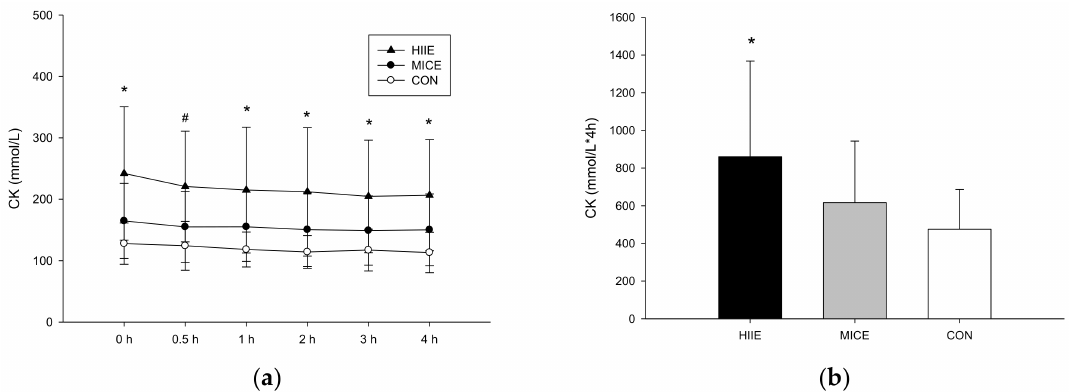
Figure 4. The plasma concentrations of CK ( a ) and CK AUC ( b ). # Mean HIIE significantly higher than the MICE trial and the CON trial ( p < 0.05). * Mean HIIE significantly higher than CON ( p <